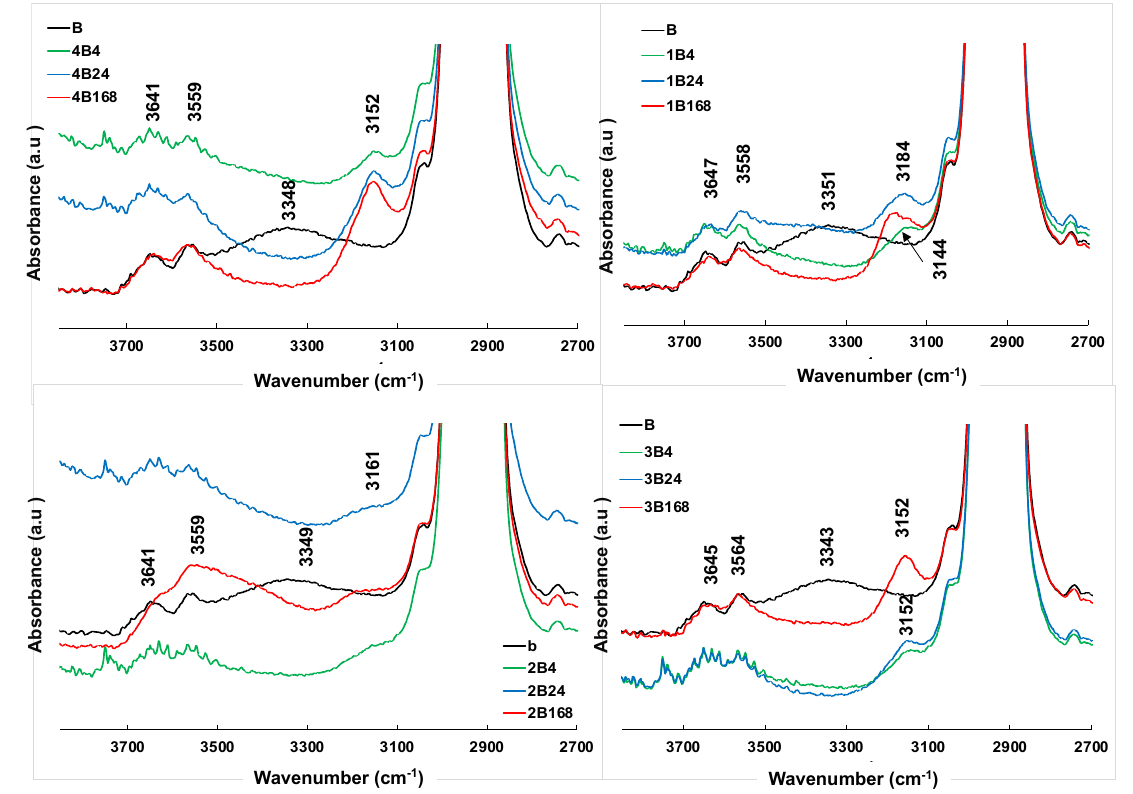
Figure 3. ATR-FTIR spectra of all samples in the 3400–2650 cm − 1 region. Figure 4 shows the trend of the area of the band at 3153 cm − 1 (3208–3103 cm − 1 baseline points) of the IL spectra with or without metal plates, as a function of the duration of the thermal treatment.